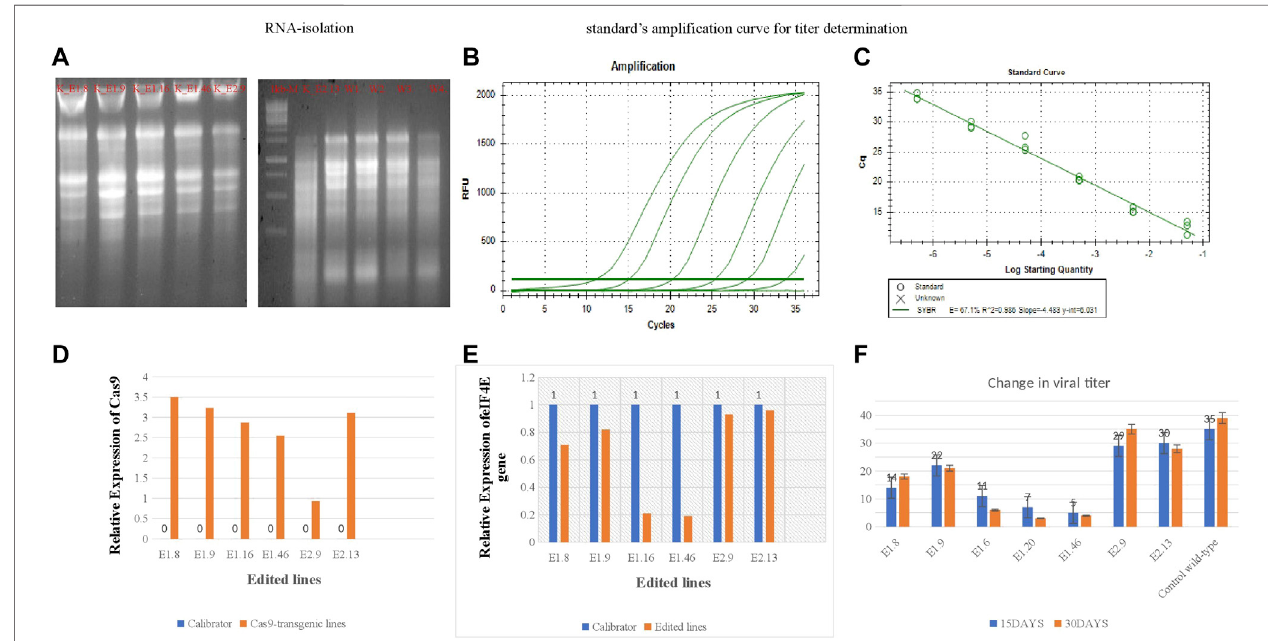
FIGURE 4 | (A) ; RNA-isolation. (B,C) : Stranded ampli fi cation curve for titre determination. (C) ; The relative expression of Cas9 in mutated lines (E1.8, E1.9, E1.16, E1.46,E2.9,E2.13) withwild-type control. (D) ; Therelative expression of Cas9 geneinmutated lines(E1.8, E1.9,E1.16,E1.46,E2.9,E2.13) (E) ;Therelative expression of eIF4E gene in mutated lines (E1.8, E1.9, E1.16, E1.46, E2.9, E2.13) with wild-type control. (F) : The absolute quanti fi cation of viral accumulation in mutated lines and wild-type susceptible control line after regular interval of 15dpi, 30dpi.